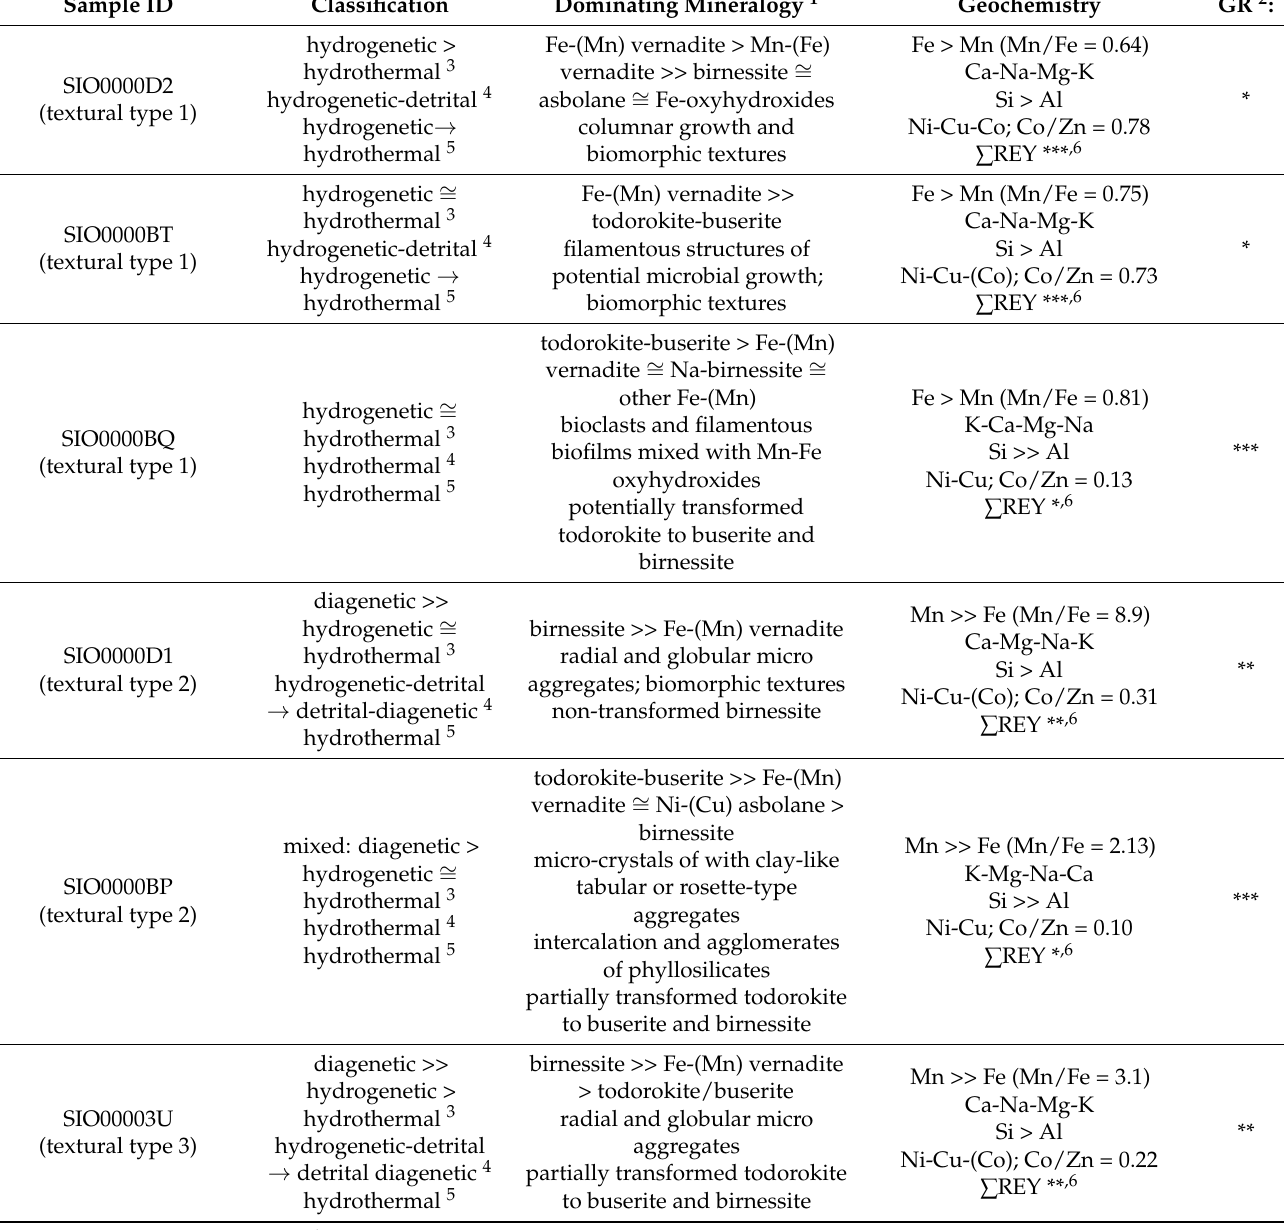
Table 6. Comparison of the most distinctive petrogenetic features of analyzed crusts from